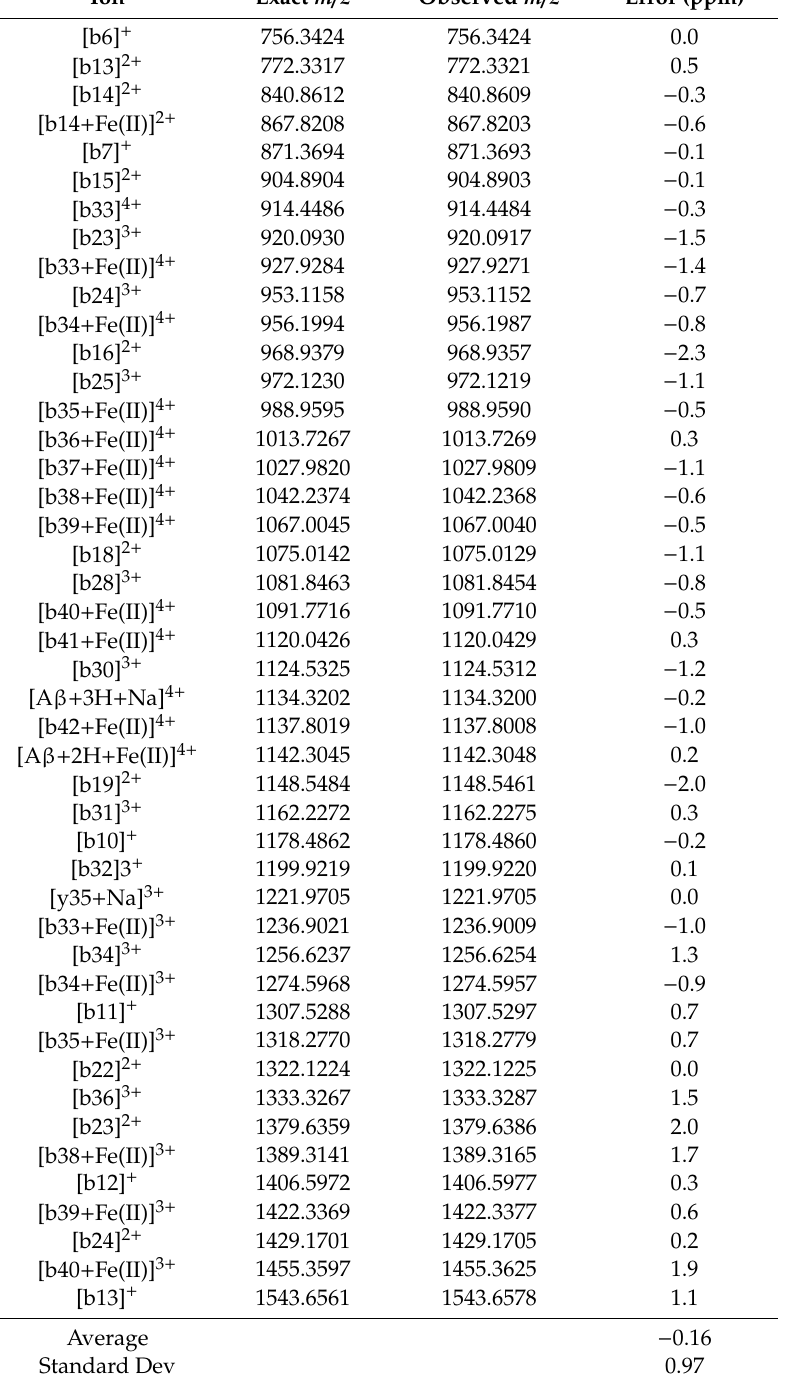
Table A3. Collision-induced dissociation of [A β +